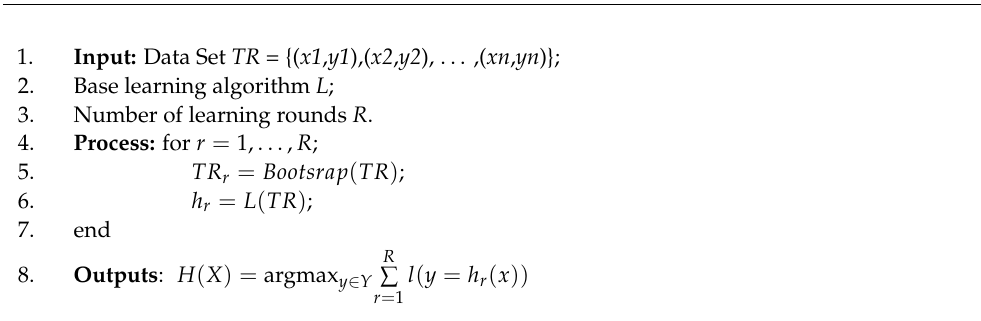
Algorithm 1. Ensemble bagged trees Algorithm.